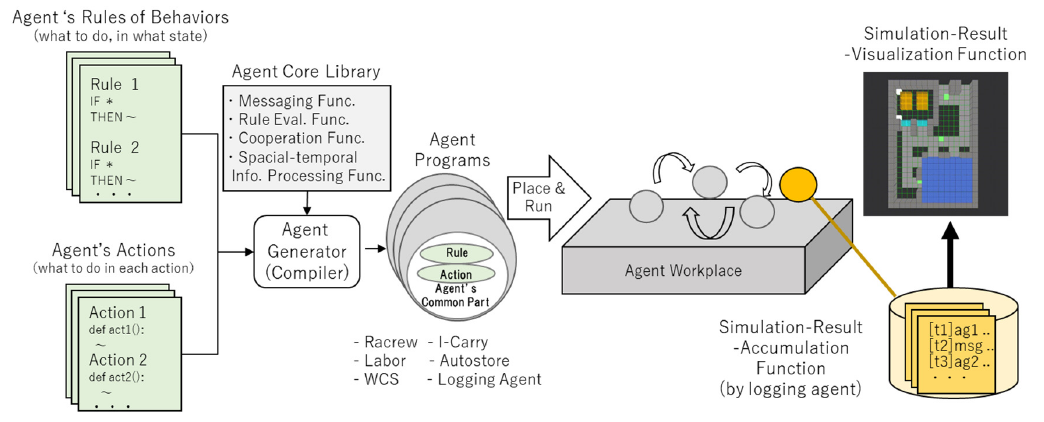
Figure 7. Composition of prototyped multi-agent modelling environment.